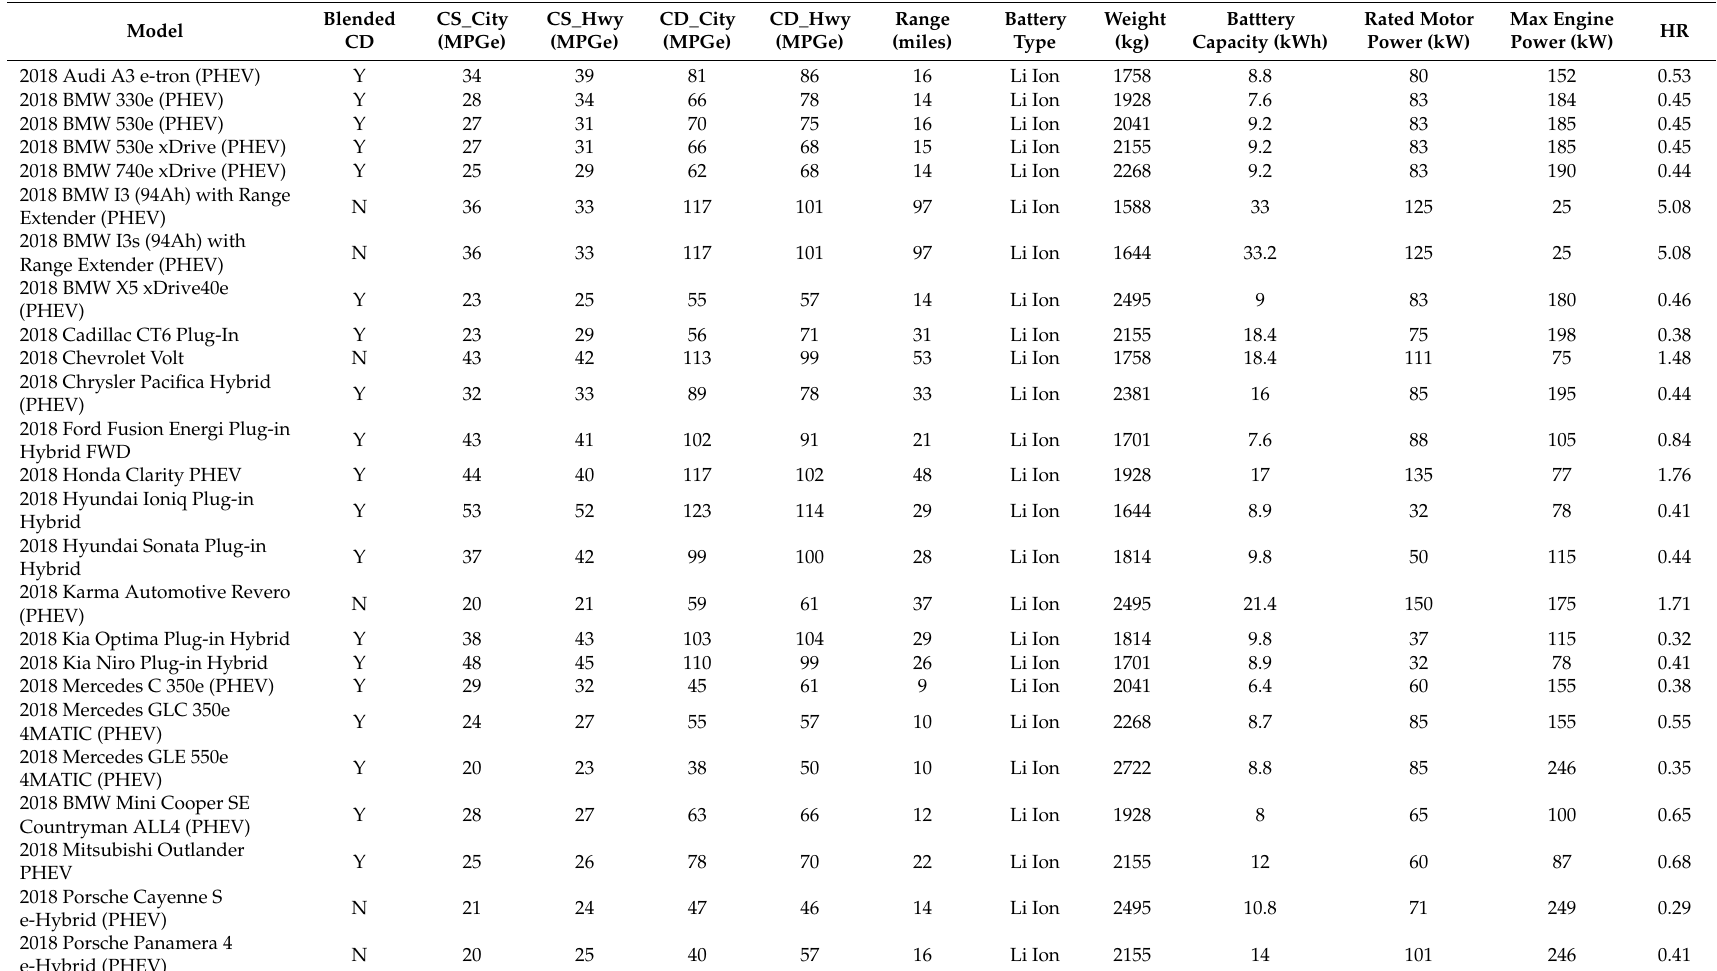
Table 1. Vehicle data for fuel economy and driving range